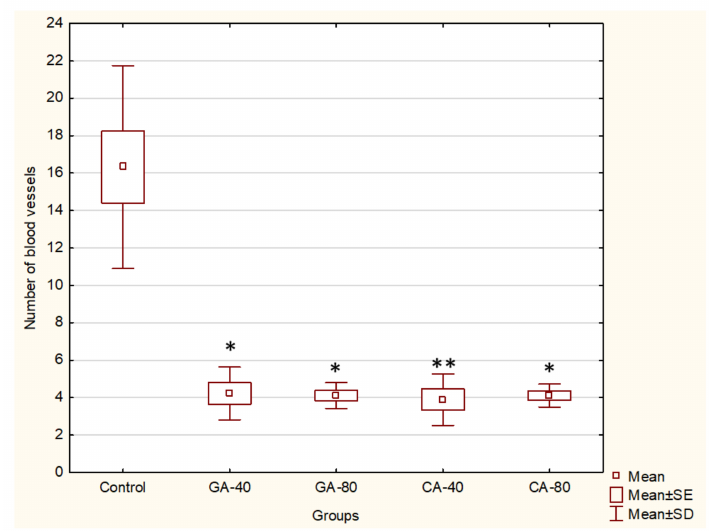
Figure 2. E ff ect of GA and CA on the microvessel density count (MVD) in the inner peritoneal lining of EAT tumor. Mice were injected intraperitoneally ( ip ) with 2.5 × 10 6 viable EAT cells and treated with GA or CA at a dose of 40 mg / kg and 80 mg / kg ip in exponential tumor growth phase on days 5, 7, 9, and 11. Mice were sacrificed on the 13th day. The results are expressed as the mean value of each experimental group ± SE of the mean of three di ff erent observations; * p < 0.05, ** p < 0.01 as compared to the control group treated with saline. Abbreviations: EAT, Ehrlich ascites tumor; GA, gallic acid; CA, ca ff eic